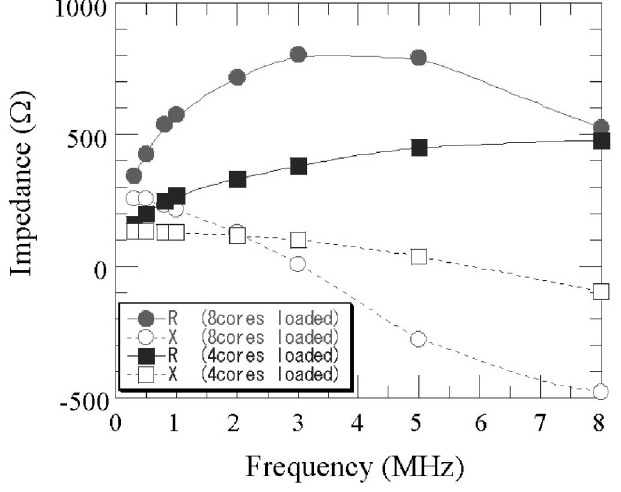
FIG. 3. Impedance property of a MA core attached with me- tallic cooling plates. Real and imaginary parts of the core impedance are indicated in solid and open marks, respectively. Attachment of metallic plates to the core from both sides leads to the null impedance (triangles). If one metallic plate is removed, such reduction can be avoided